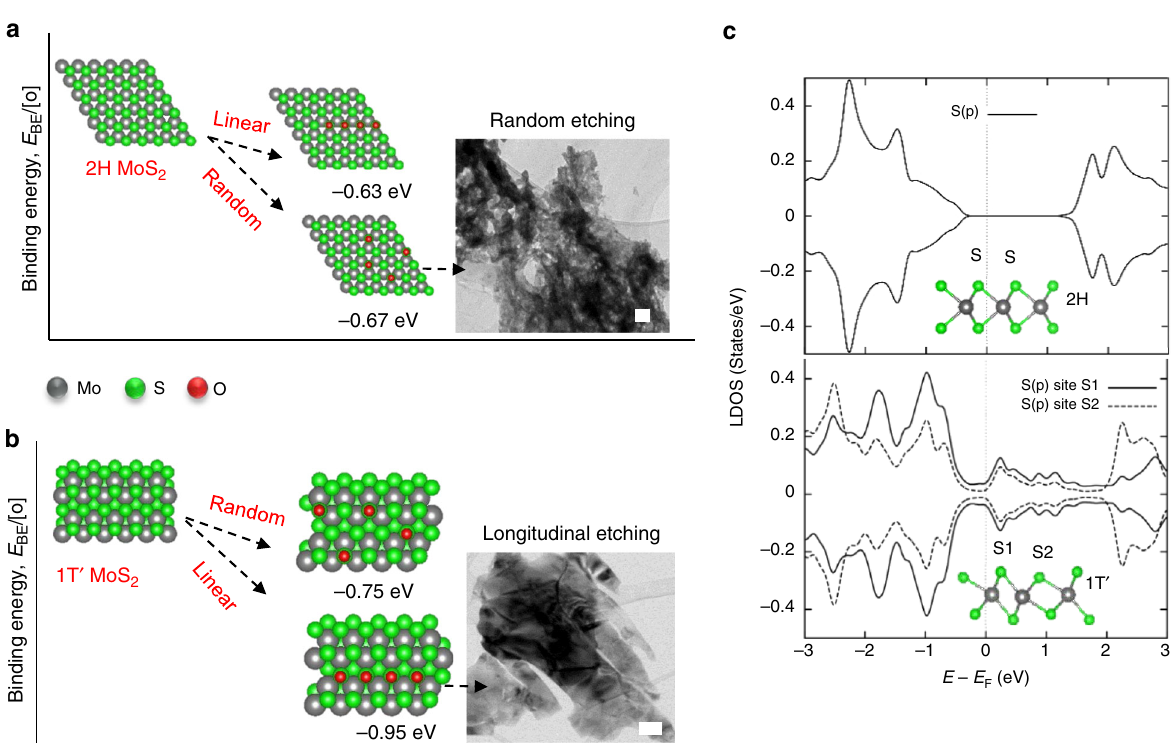
Fig. 2 Oxygenation on the surface of MX 2 . a , b Difference in oxygen binding energies at 2H and 1T ′ MoS 2 . While 2H phase prefers random binding of oxygen at surface, 1T ′ phase prefers a linearized pattern. Insets show TEM images of randomly and linearly etched MoS 2 sheets. Scale bars, 100 nm. c The local density of states diagrams representing the similar (top) and different (bottom) density of states for S atoms in 2H and 1T ′ phases.